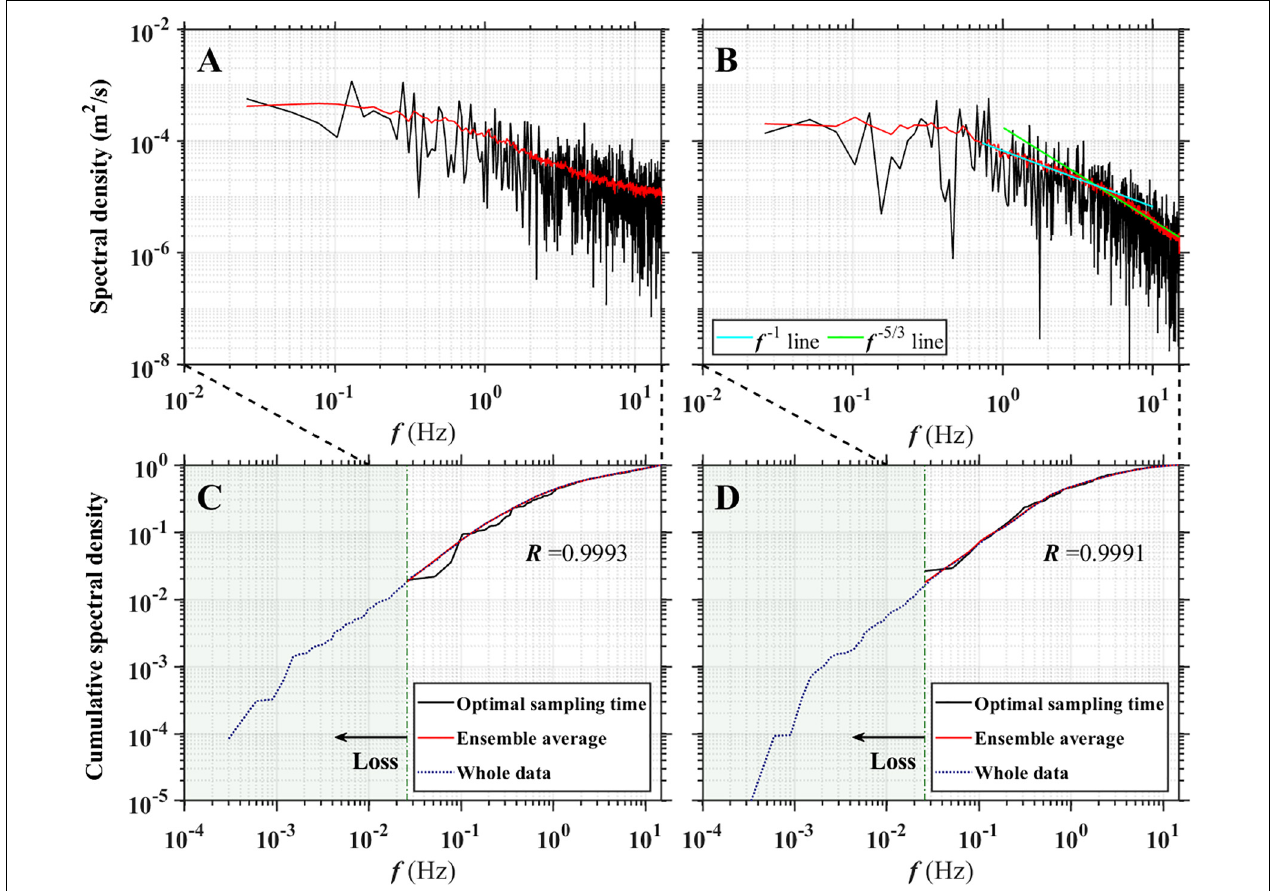
FIGURE 6 | Power spectral densities of (A) u ’ and (B) w ’ and cumulative spectral densities of (C) u ’ and (D) w ’; The black line means the spectrum of a randomly chosen data having a length of optimal sampling time and the maximum frequency of power spectral densities is half of the sampling